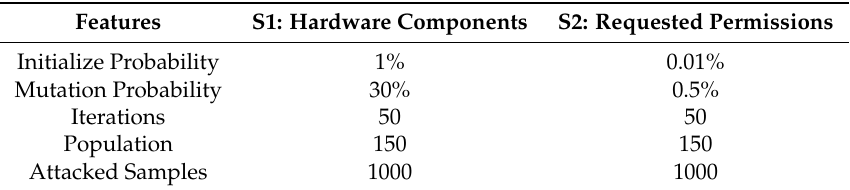
Table 4. The parameters of our approach.